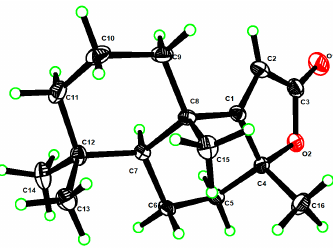
Figure 2. Structure of 3 determined by single-crystal X-ray diffraction, CCDC code: 2,238,307 [34].